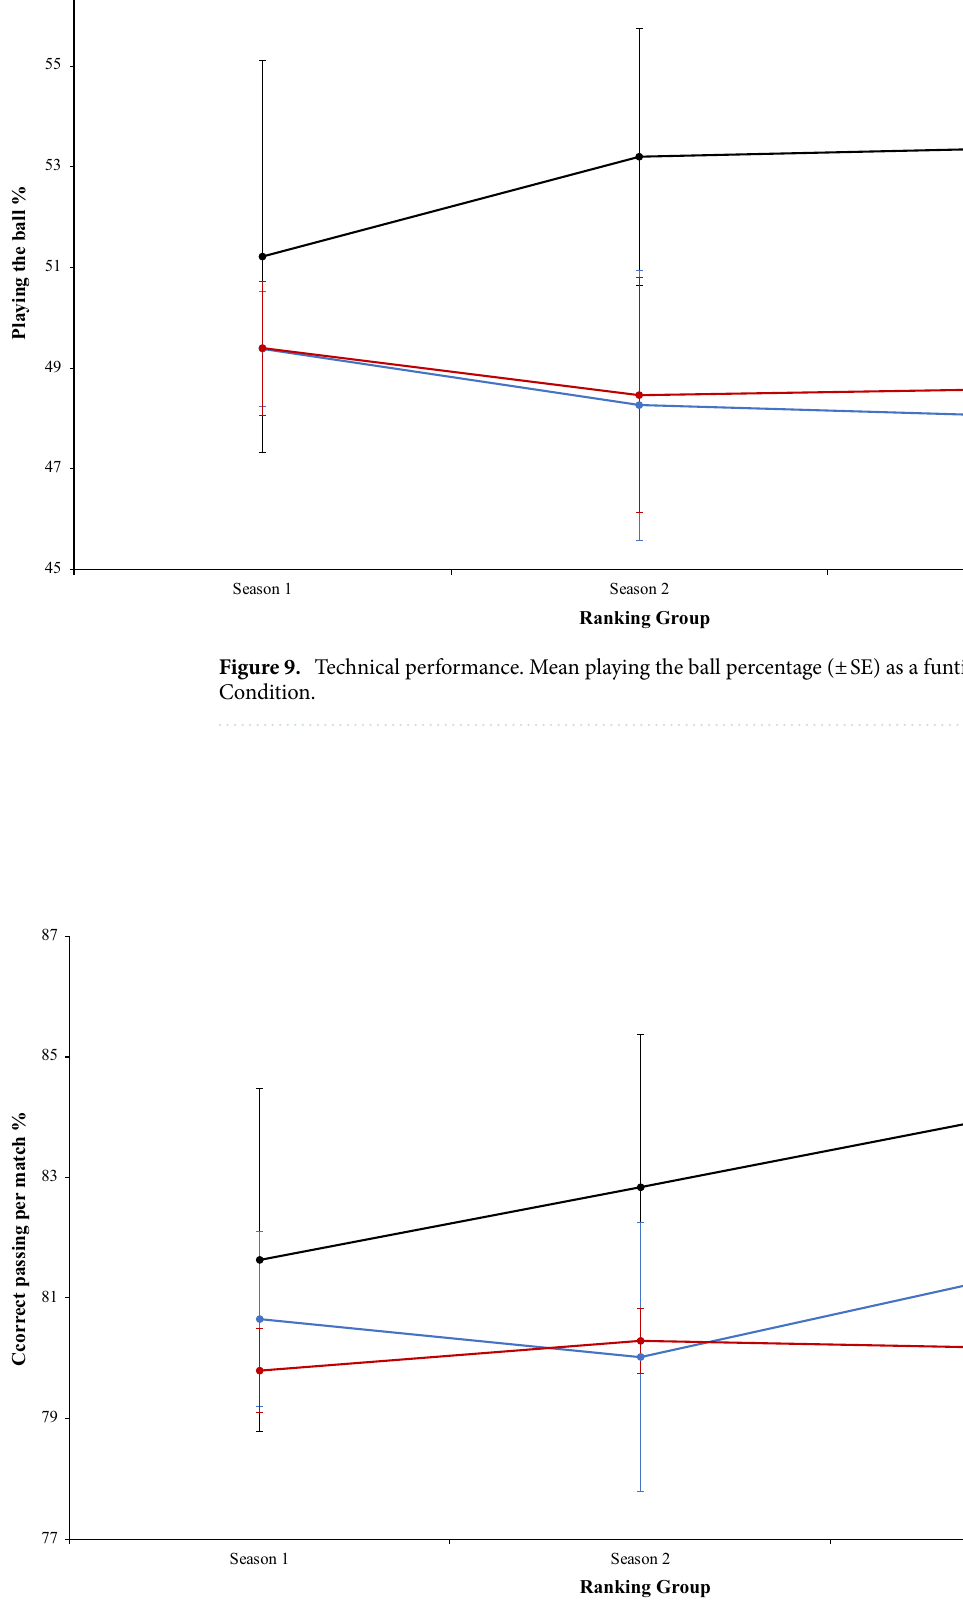
Figure 10. Technical performance. Mean correct passing per match percentage (± SE) as a funtion of Ranking and Season